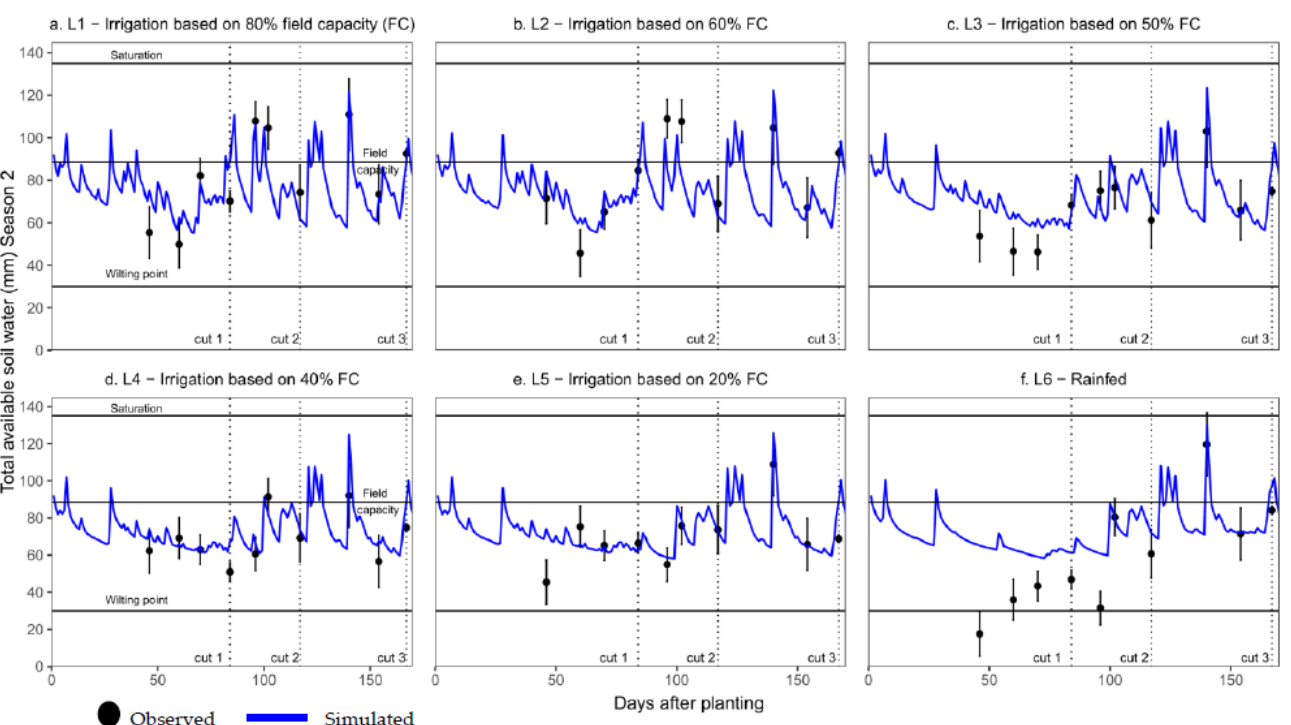
Figure 11. Observed and simulated total available soil water (TAW) under different irrigation treatments during the second growing season (2021/22) of Guinea grass ( Megathyrsus maximus cv. Agrosavia sabanera). The error bars represent standard deviations. ( a ). TAW for the treatment L1—irrigation based on 80% field capacity (FC); ( b ). TAW for the treatment L2—irrigation based on 60% FC; ( c ) TAW for the treatment L3—irrigation based on 50% FC; ( d ) TAW for the treatment L4—irrigation based on 40% FC; ( e ) TAW for the treatment L5—irrigation based on 20% FC; ( f ) TAW for the treatment